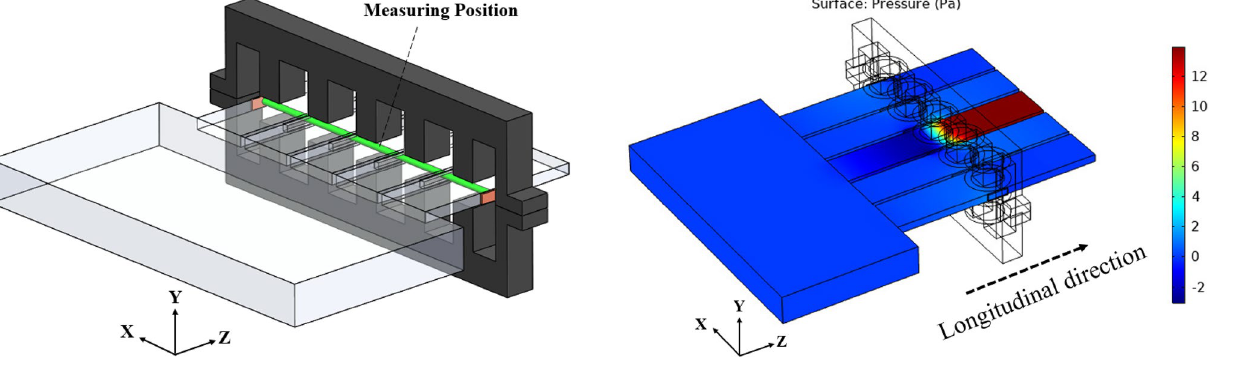
Fig. 8 The axial line of the electrodes (the evaluation location of the fluid velocity)